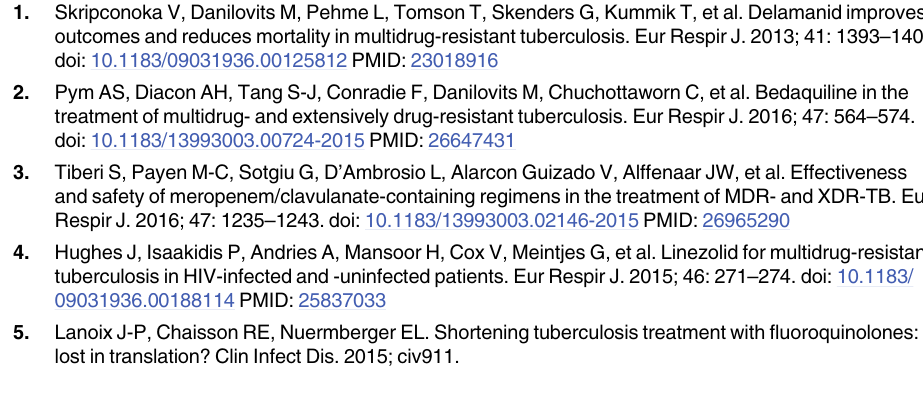
S7 Fig. Sensitivity analysis: influence of individual parameter estimates on overall novel regimen impact. Partial rank correlation (adjusted for other parameters) was calculated for each parameter with the percent reduction in TB mortality (or, for RR TB regimens, the per- cent reduction in RR TB mortality) achieved by a novel regimen that met all intermediate tar- get criteria. S8 Fig. Primary results with contact structure changed to heterogeneous, as described in S3 Methods. S9 Fig. Sensitivity analysis for calibration method. The calibration method used in the pri- mary analysis, in which all simulations that fell inside of uncertainty intervals were included in the analysis with equal weight, is compared to an alternative approach weighted according to a Gaussian-based likelihood function as described in S3 Methods. In order to summarize many results in a single figure, regimen characteristics not being varied are set at an intermediate baseline; scalability is included among the characteristics varied; and reduction in mortality is shown relative to projections without any novel